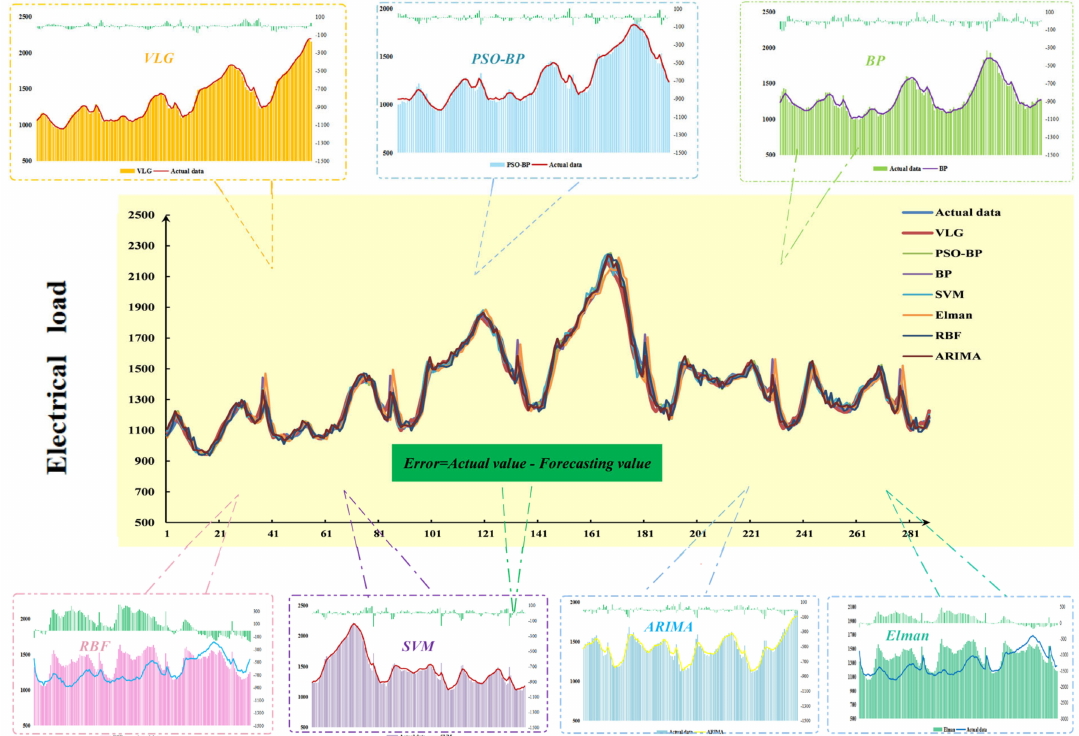
Figure 4. The fitting situation and error description of the VLG prediction system and seven comparative prediction models based on spring dataset of South